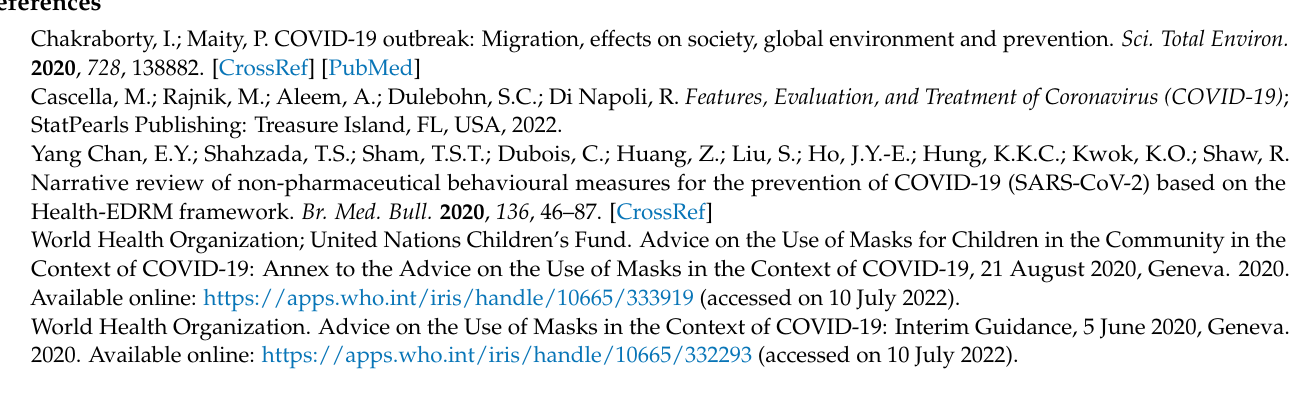
Table S9. Post hoc tests for incorrect mask wearing in different situations in the schools between class memberships based on the estimated marginal means, Table S10. Post hoc tests for incorrect mask wearing in different variants of mask wearing between class memberships based on the estimated marginal